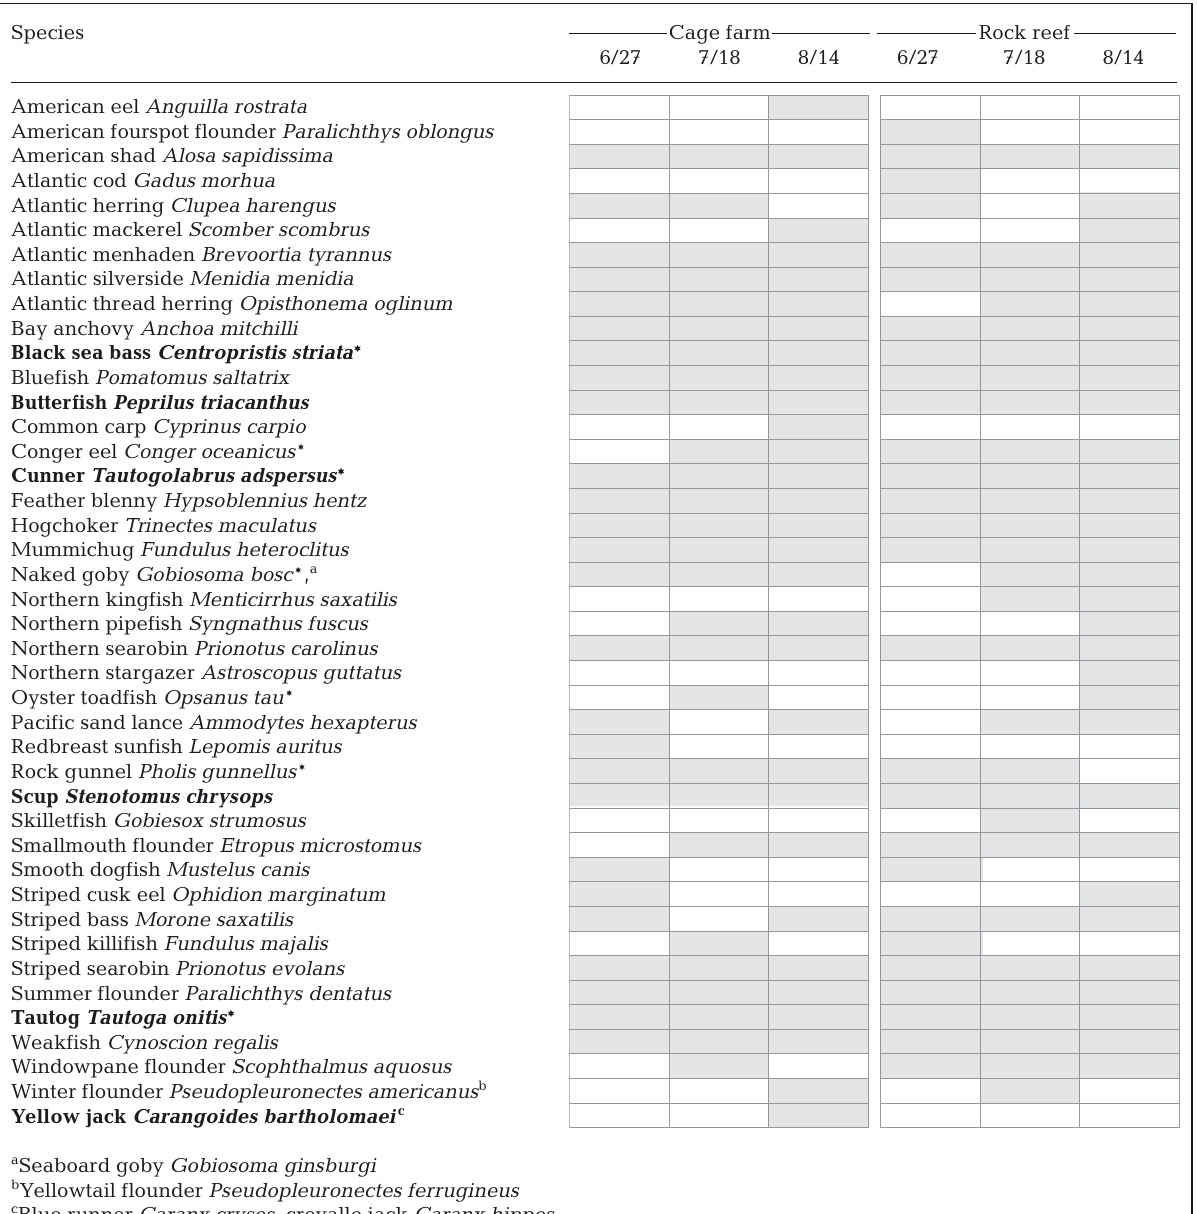
Table 2. Fish species detected using eDNA metabarcoding from seawater samples collected on 3 dates (given as mo/d) near the cage farm and rock reef are indicated by gray shading. In cases where species have similar DNA sequences and cannot be dis- tinguished, the species known to be present based on geographic range are listed with other possible identifications shown in the footnotes. Species that were also observed in video during the 2017 field season are indicated in bold , and species visually observed in or falling out of cages on deck are noted with an